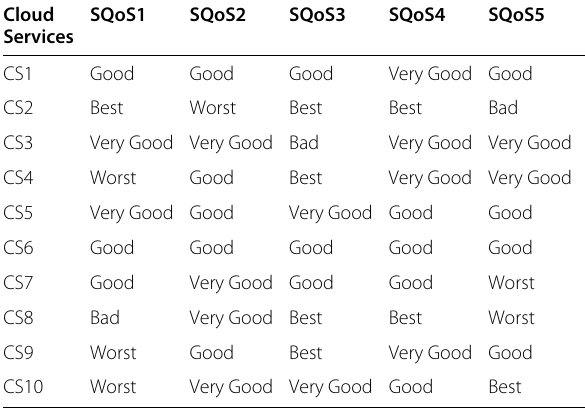
Algorithm 1: BSS Technique